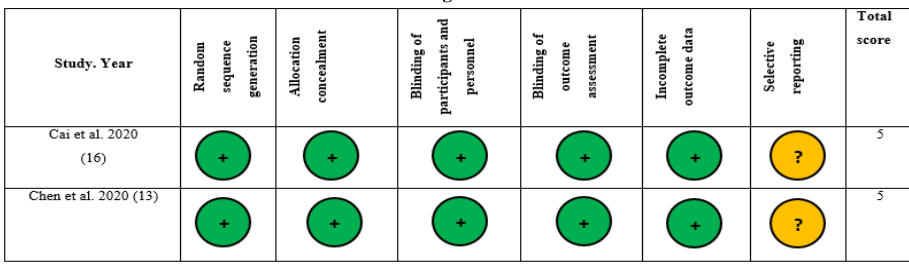
Table 4. Risk of bias according to Cochrane Collaboration’s